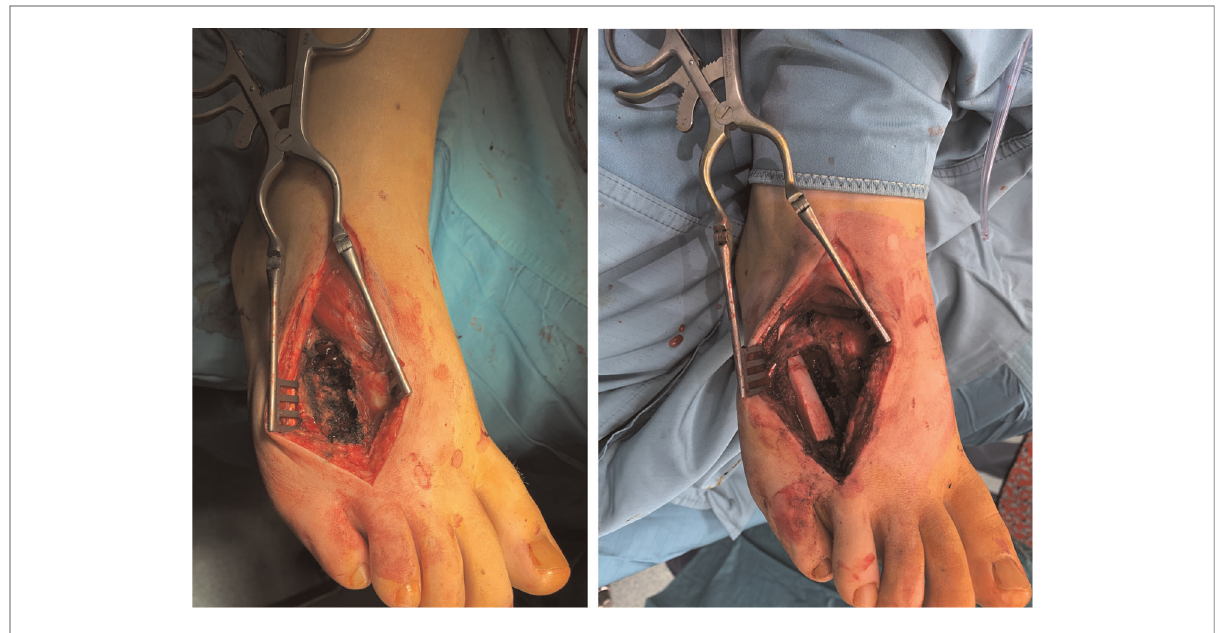
FIGURE 2 Intra-operative picture after en-bloc resection of tumor ( A ) and fi bular grafting ( B